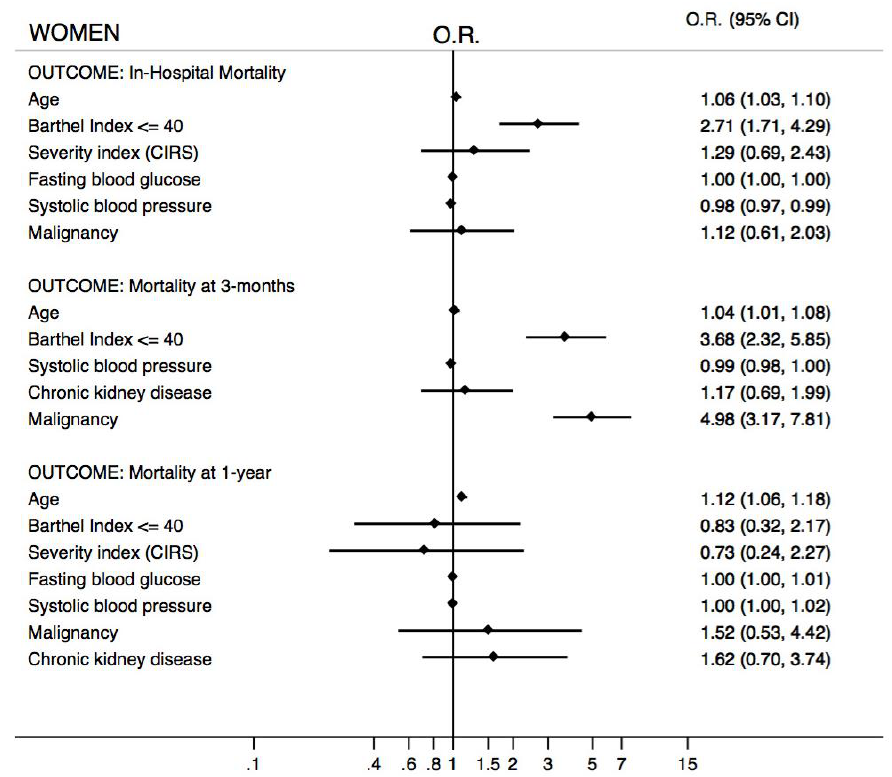
Figure 6. Multivariate analysis according to in-hospital, 3-month, and 1-year mortalities in the female population (OR = odds ratio; 95% CI = 95% confidence interval).